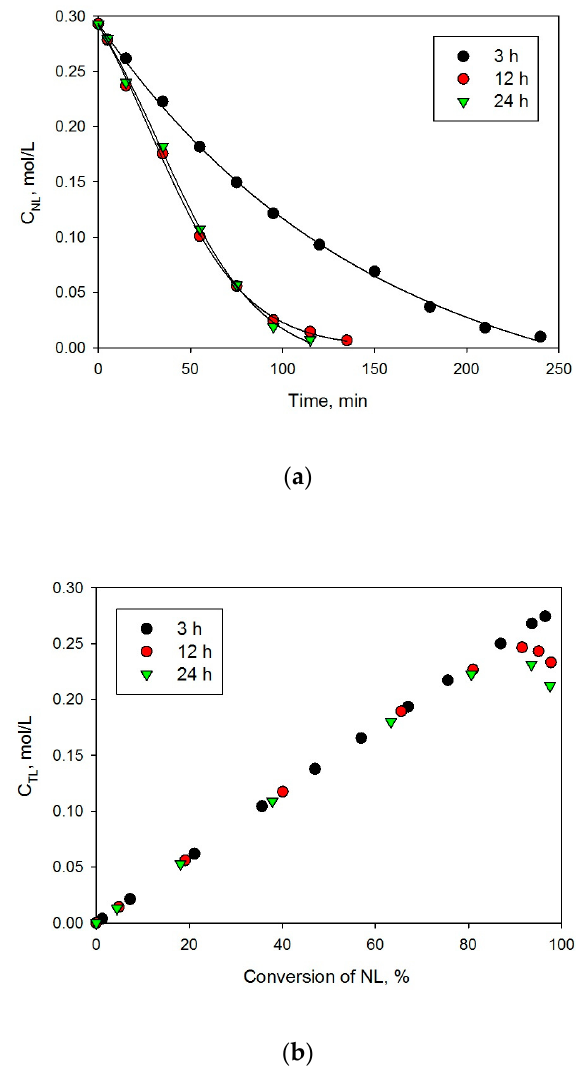
Figure 6. Dependence of NL consumption on time ( a ) and accumulation of TL on the NL conversion ( b ) at variation of duration of the catalyst reduction (1.5 g of NL, 0.1 g of catalyst, 40 mL of hexane, 250 °C, 6 MPa).